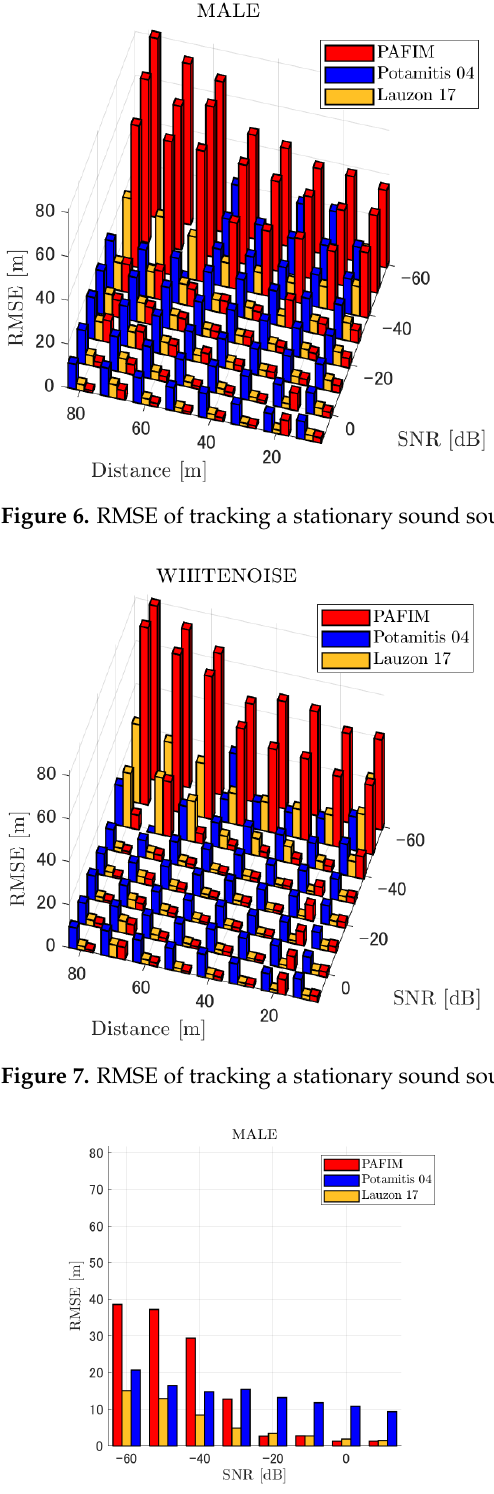
Figure 8. RMSE of tracking a stationary sound source emitting male voice (focusing on source horizontal distance = 30